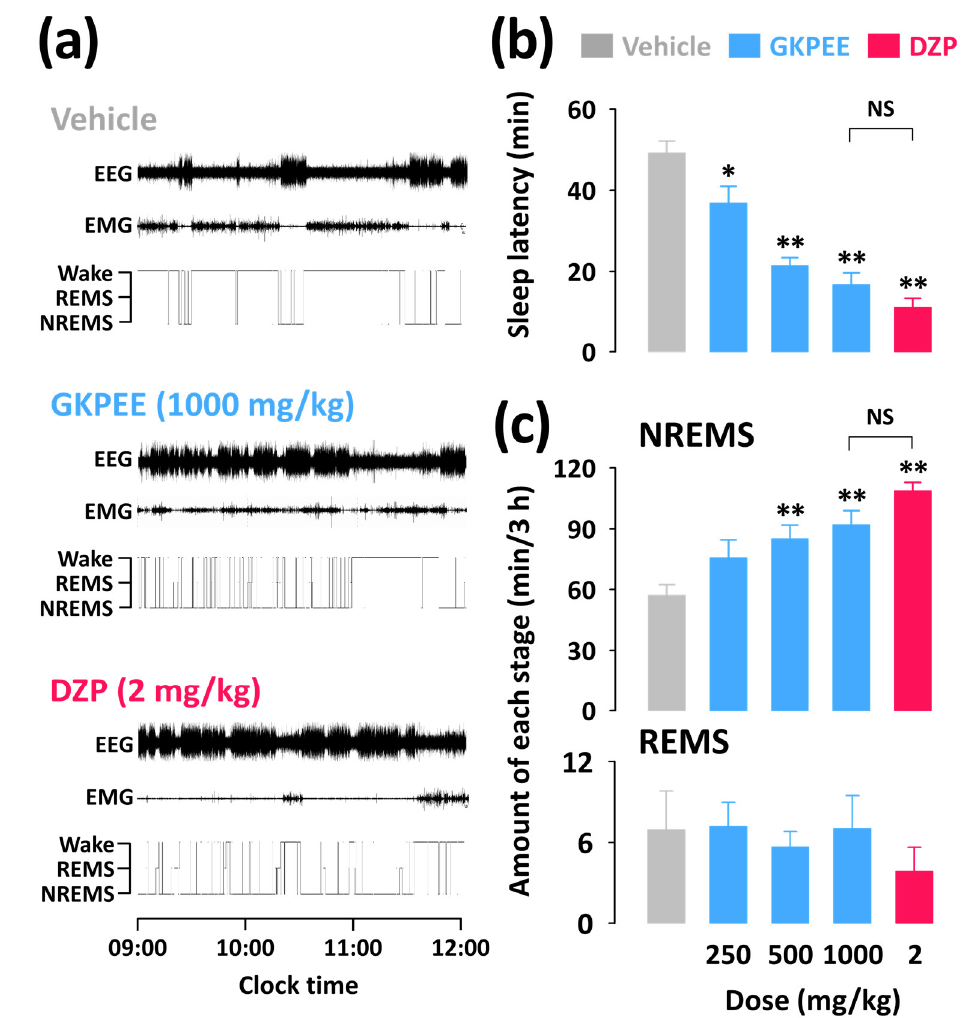
Figure 2. Effects of GKPEE and DZP on sleep profiles in mice. ( a ) Examples of EEG/EMG signals and hypnograms in a mouse treated with GKPEE and DZP. ( b ) Changes in sleep latency by administration of GKPEE and DZP. ( c ) NREMS and REMS amounts during the 3 h period following injection of GKPEE and DZP. Columns represent the mean ± SEM of 7–8 mice. * p < 0.05 and ** p < 0.01, are significant compared to the vehicle (Dunnett’s test). DZP, diazepam; EEG, electroencephalogram; EMG, electromyogram; GKPEE, green kiwifruit peel ethanol extract; NS, no significance; REMS, rapid eye movement sleep; NREMS, non-REMS; SEM, standard error of mean; Wake, wakefulness.